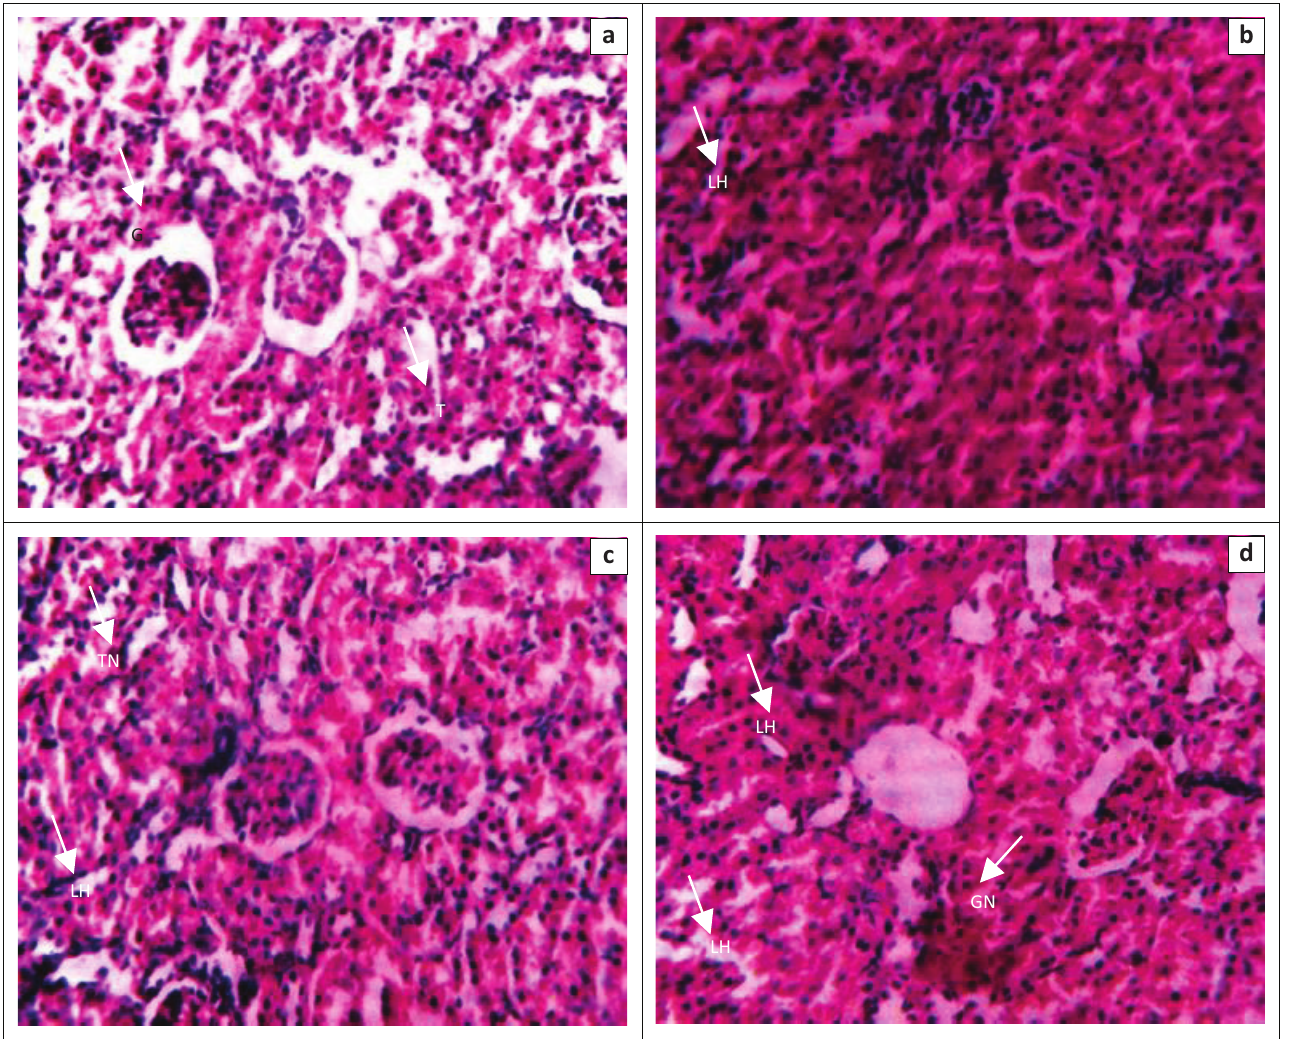
G, glomerular; T, normal tubules; LH, lymphocyte hyperplasia; TN, tubular necrosis; GN, glomerulus necrosis. FIGURE 3: Photomicrograph showing the kidney section of (a) the control group (1 mL/kg distilled water) shows normal architecture tubules (T) and glomerulus; (b) treated with 500 mg/kg of ethyl acetate extract shows moderate and slight lymphocyte hyperplasia; (c) treated with 1000 mg/kg of ethyl acetate extract shows slight lymphocyte hyperplasia; (d) treated with 1500 mg/kg of ethyl acetate extract shows slight tubular necrosis, slight glomerular necrosis with lymphocyte hyperplasia (haematoxylin and eosin stain; original magnification ×